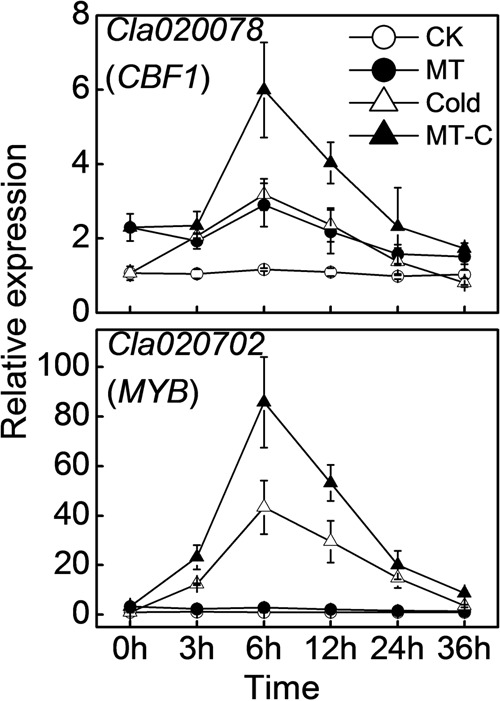
The dynamic response of the expression of Cla020078 (CBF1) and Cla020702 (MYB) to melatonin or/and cold stress. The plants were treated as described in Figure 1 and the leaf samples were harvested at indicated times (h) after cold treatment. Data are the means of four replicates (±SD). Means denoted by the same letter did not significantly differ at P < 0.05 according to Tukey’s test.